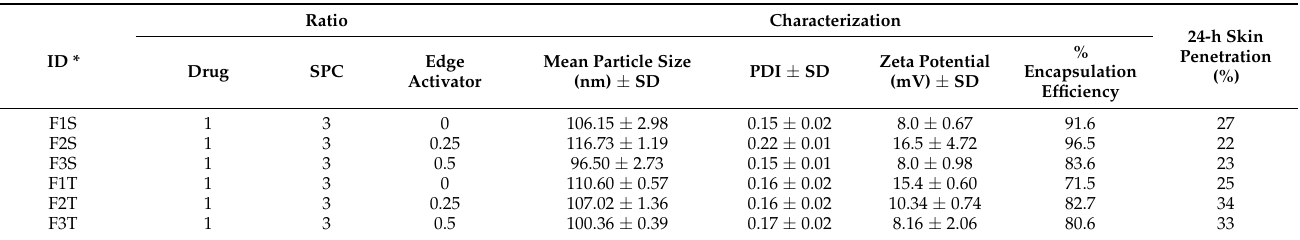
Table 1. Physical characteristics of R-carvedilol-loaded transfersomes prepared with Tween 80 or sodium cholate and comparison of the ex vivo skin penetration.